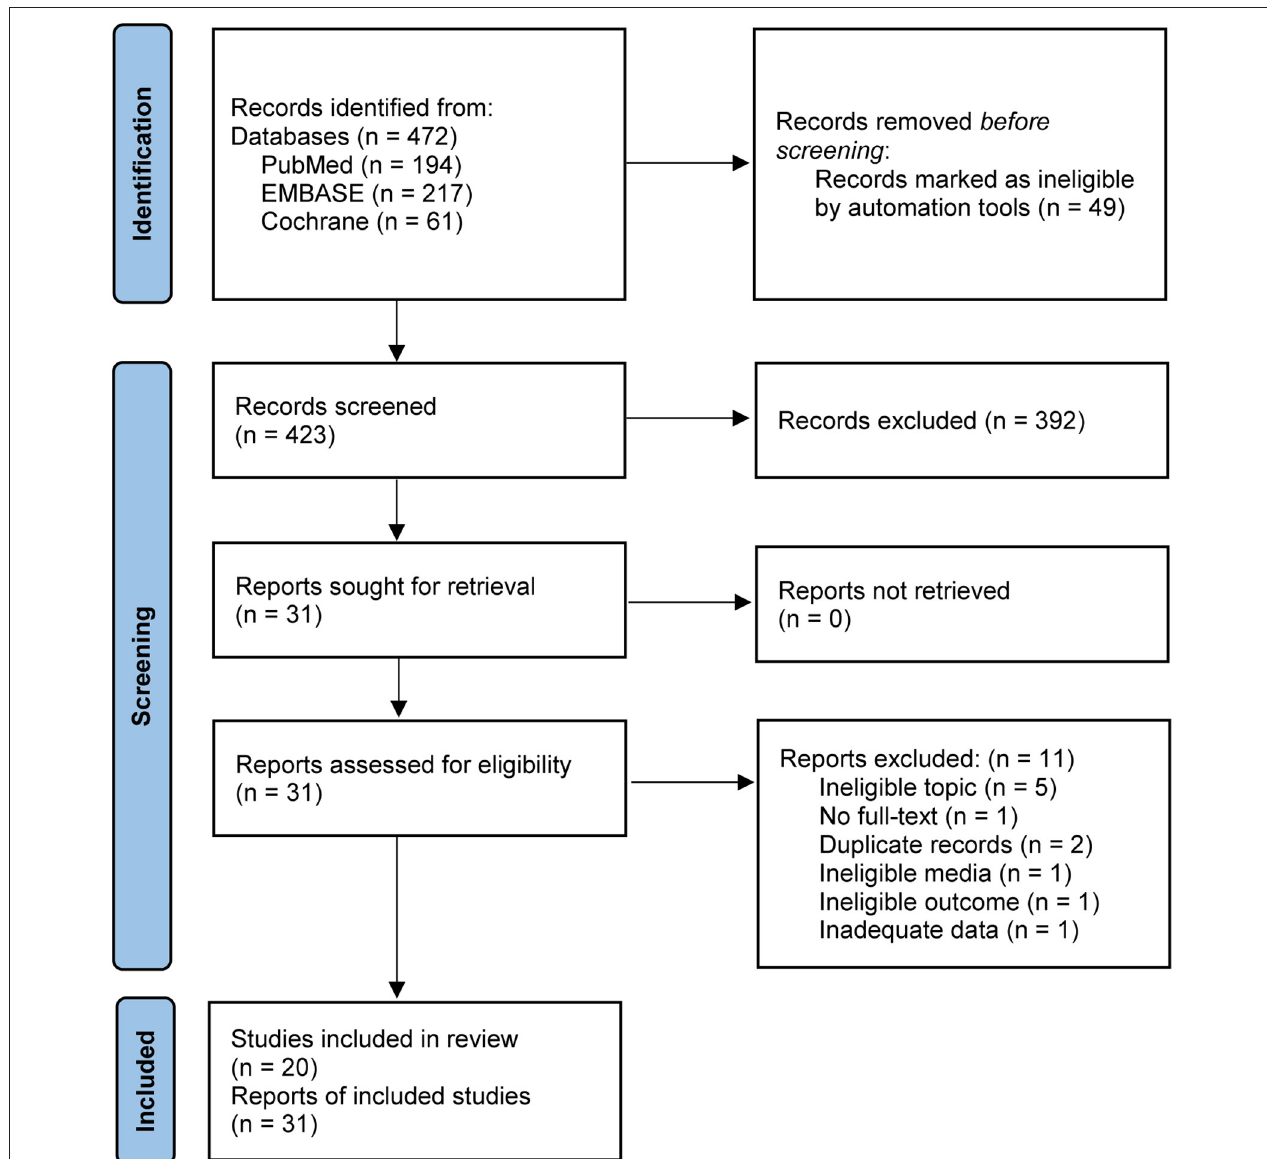
FIGURE 1 | Flow diagram of searching and selecting studies. We searched PubMed, EMBASE, and the Cochrane Library to determine potentially eligible